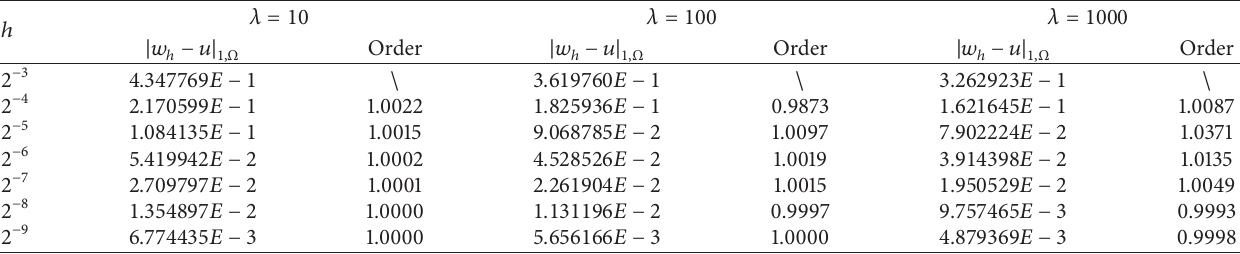
Table 1: The errors in energy norm.